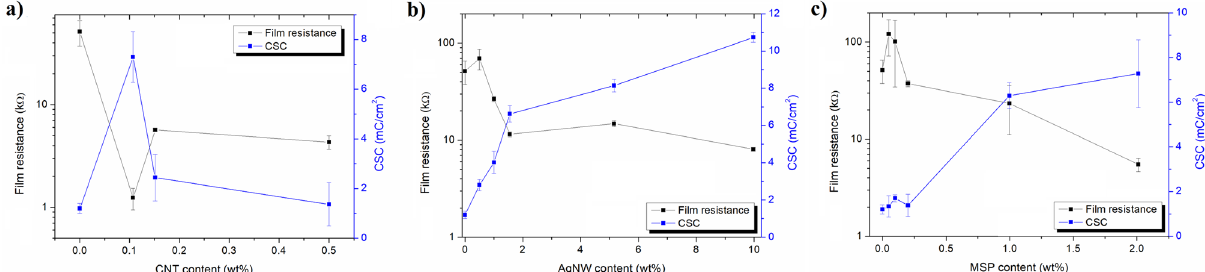
Figure 4. Electrochemical percolation threshold for EDL-based composites. Film resistance/charge storage capacity (CSC) plots of EDL/CNT ( a ), EDL/AgNW ( b ) and EDL/MSP ( c ) composites; n = 3. Film resistance values were determined using an equivalent circuit modelling of EIS data (R 3 ), while CSC values were calculated from CV curves.